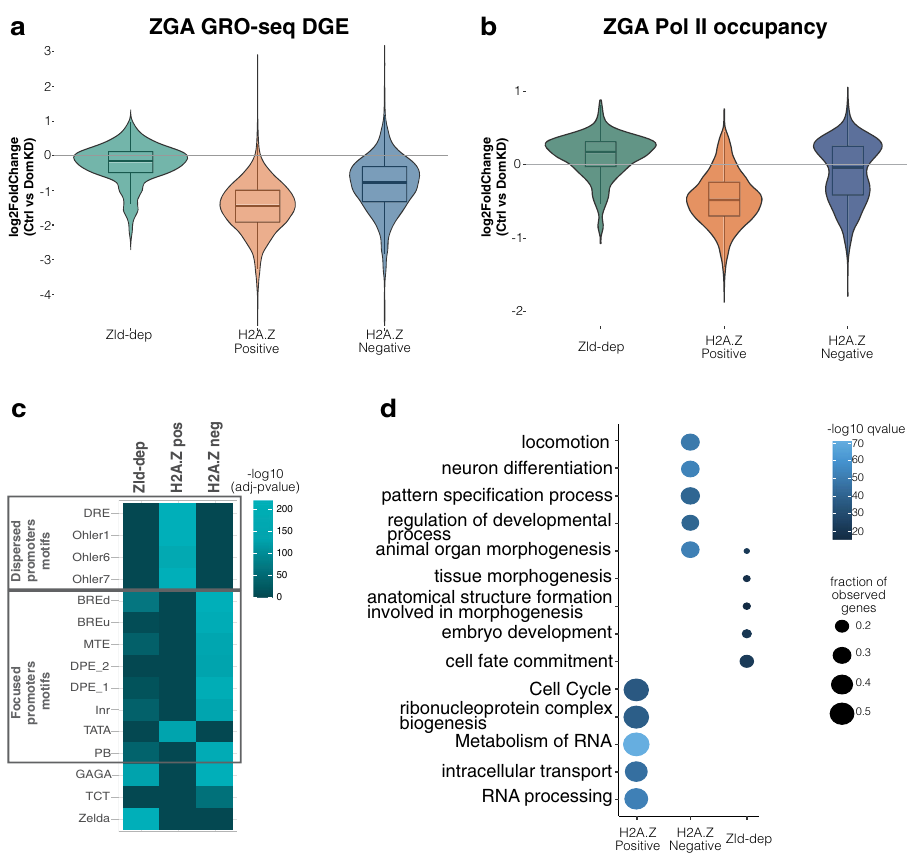
Fig. 3 Transcription of housekeeping genes is affected in DomKD embryos. a Violin plot showing the differential gene expression (DGE) as log2FoldChanges in gene expression of Ctrl vs DomKD in Zld-dependent, H2A.Z positive and H2A.Z negative genes measured by GRO-seq. See also Supplementary Fig. 3j. n = 3 biologically independent experiments per genotype. b Violin plot of the log2FoldChange for Pol II occupancy (Rpb3 ChIP-seq) per unique promoter of Zld-dependent, H2A.Z positive and H2A.Z negative promoters. See also Supplementary Fig. 3i. n = 2 biologically independent experiments per genotype. a , b All groups are signi fi cantly different by pairwise comparison, Wilcoxon rank sum test with continuity correction, two-sided, p- value < 2.2e – 16. Box plots ( a , b ) depict the median and the interquartile range (IQR) from the 1 st to the 3 rd quartile. Whiskers indicate the upper (Q3 + 1.5*IQR) and lower edge (Q1 − 1.5*IQR). c Motif enrichment analysis of core promoter elements in Zld-dependent (Zld-dep), H2A.Z positive (H2A.Z pos) and H2A.Z negative (H2A.Z neg) promoters. d Gene set enrichment analysis using Metascape 56 showing the top 5 most signi fi cant GO terms per group (Zld-dep, H2A.Z pos and H2A.Z neg). Each GO-term is supported by the color scale in -log10 q -value and the fraction of observed genes presenting the proportion of observed genes in the respective GO term. Data representation was arranged as proposed by ref. 115 . See also Supplementary Fig. 3l. c , d Source data are provided as a Source Data fi